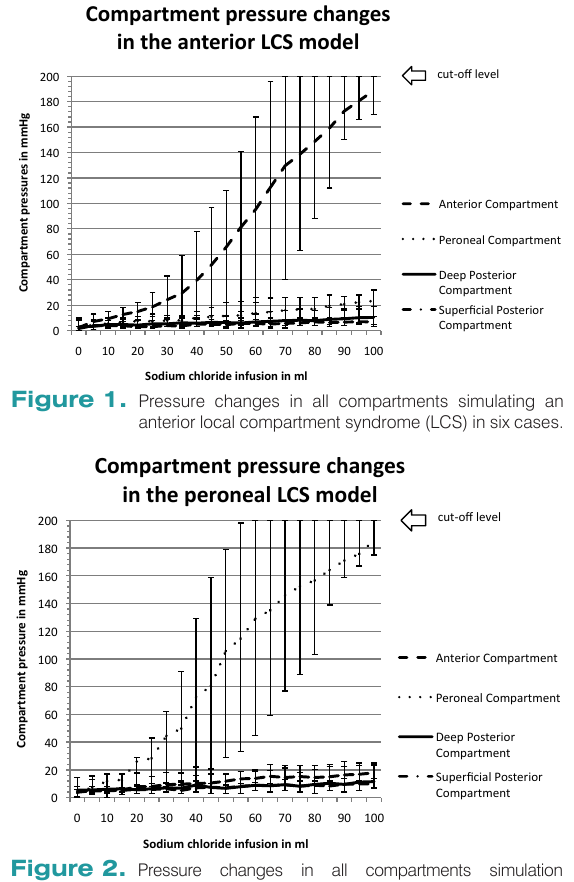
Figure 2. Pressure changes in all compartments simulation a peroneal local compartment syndrome (LCS) in six